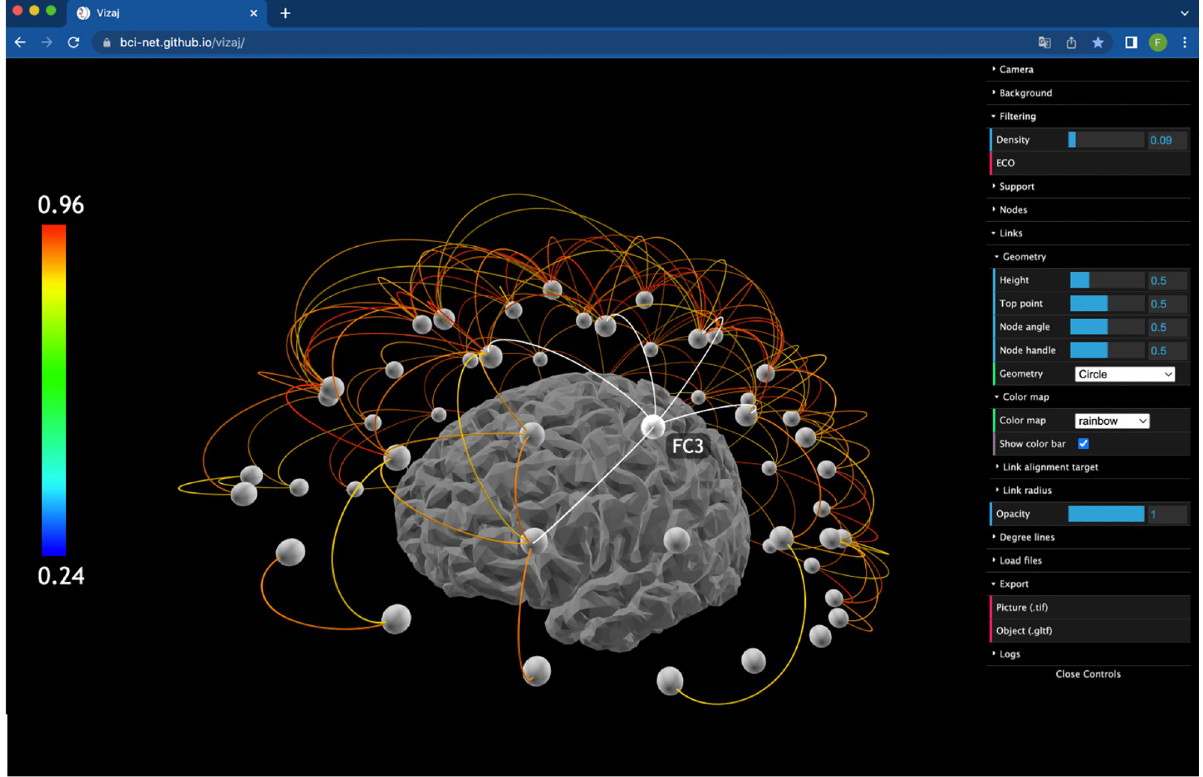
Fig 2. Screenshot of the Vizaj ’s graphical user interface (GUI). Spatial networks are built in a 3D scene. The network can be zoomed and rotated via the cursor input. When the cursor hit a node, its connections and label are dynamically highlighted. On the right, all the controlling parameters are listed and accessible to the